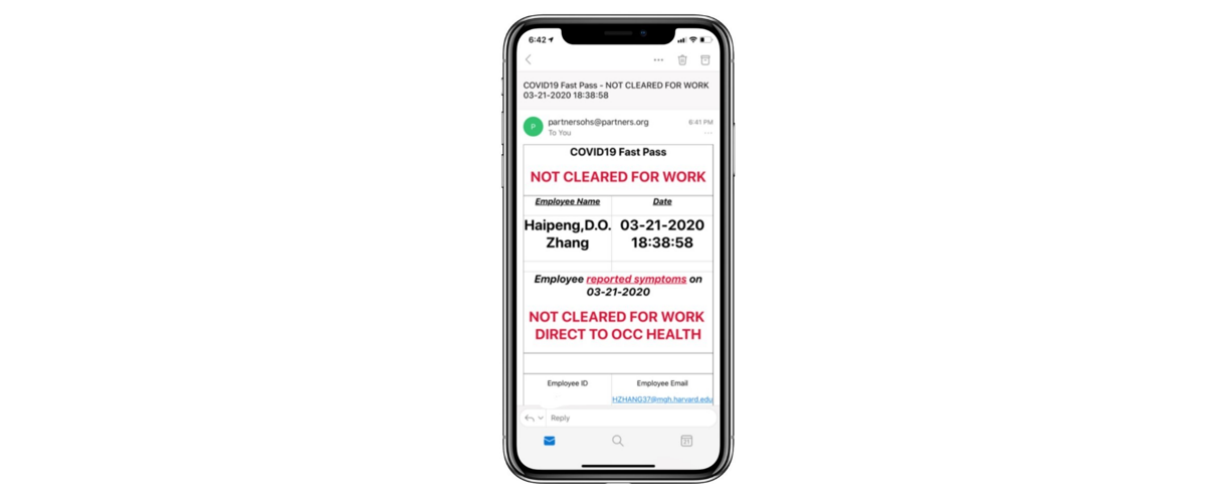
Figure 3. “Not Cleared for Work” screen of the COVID Pass application.